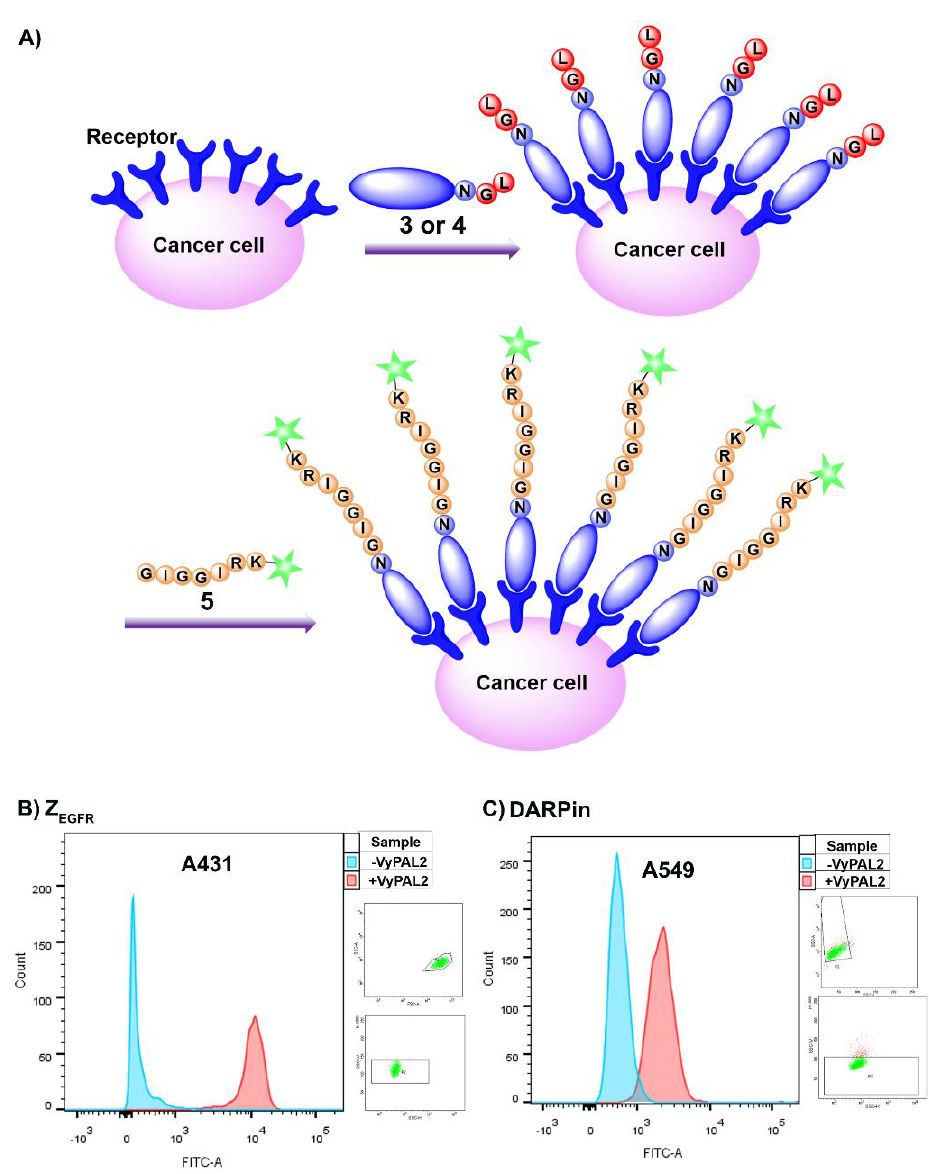
Figure 7. Labeling of cell surface-bound affibody 3 and DARPin 4 . ( A ) Reaction scheme of labelling protein ligands which are pre-bound to cell surface receptors; ( B ) flow cytometry characterization of A431 cells with pre-bound Z EGFR 3 on cell surface after incubation with 5 in the presence or absence of VyPAL2; ( C ) flow cytometry characterization of A549 cells with pre-bound DARPin 4 on cell surface after incubation with 5 in the presence or absence of VyPAL2.